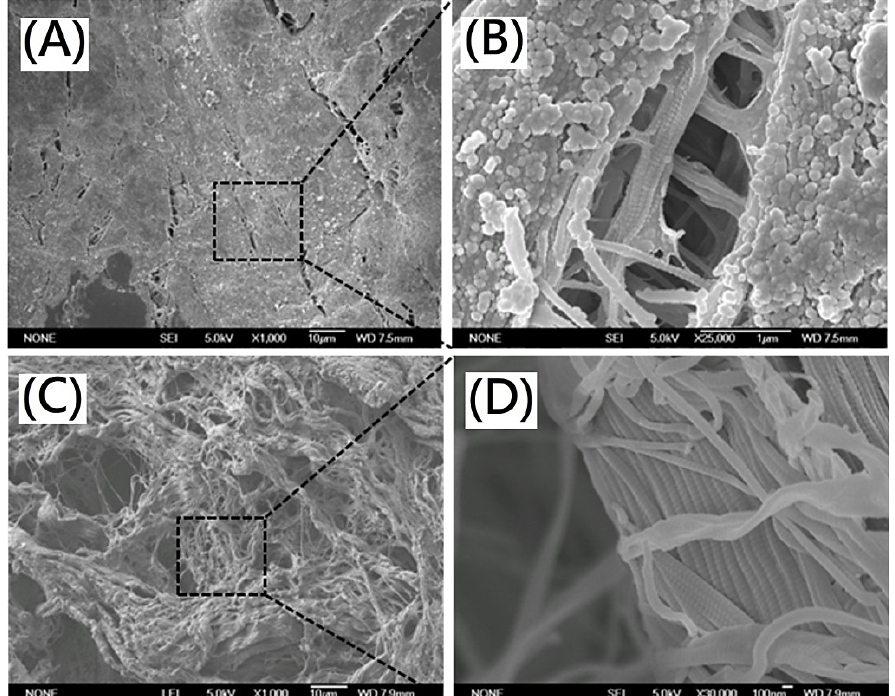
Figure 1. SEM images of ( A ) original porcine dermis(magnification 1000×) ( B ) original porcine dermis(magnification 25,000×) ( C ) decellularized porcine dermis after decellularization (magnification 1000×) ( D ) decellularized porcine dermis after decellularization (magnification 30,000×).